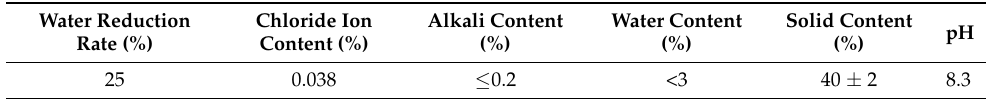
Table 1. Chemical composition of cement, fly ash, and silica fume (% by mass).